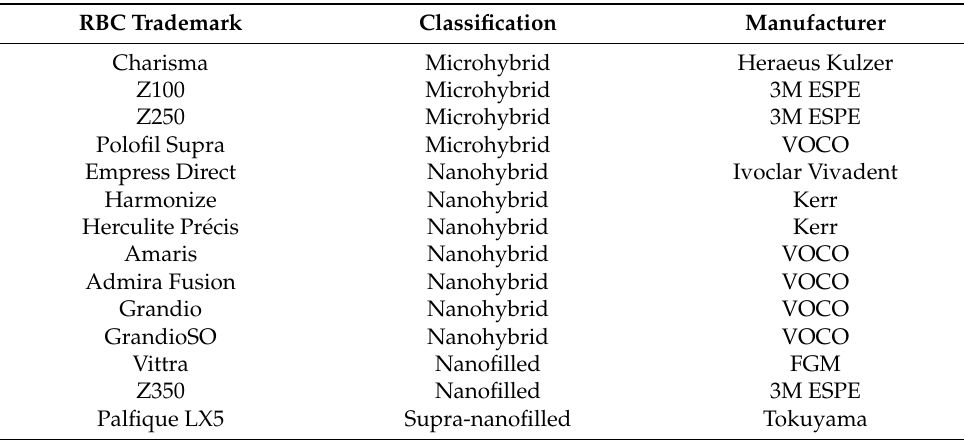
Table 1. Resin-based composites (RBC) used in this study.